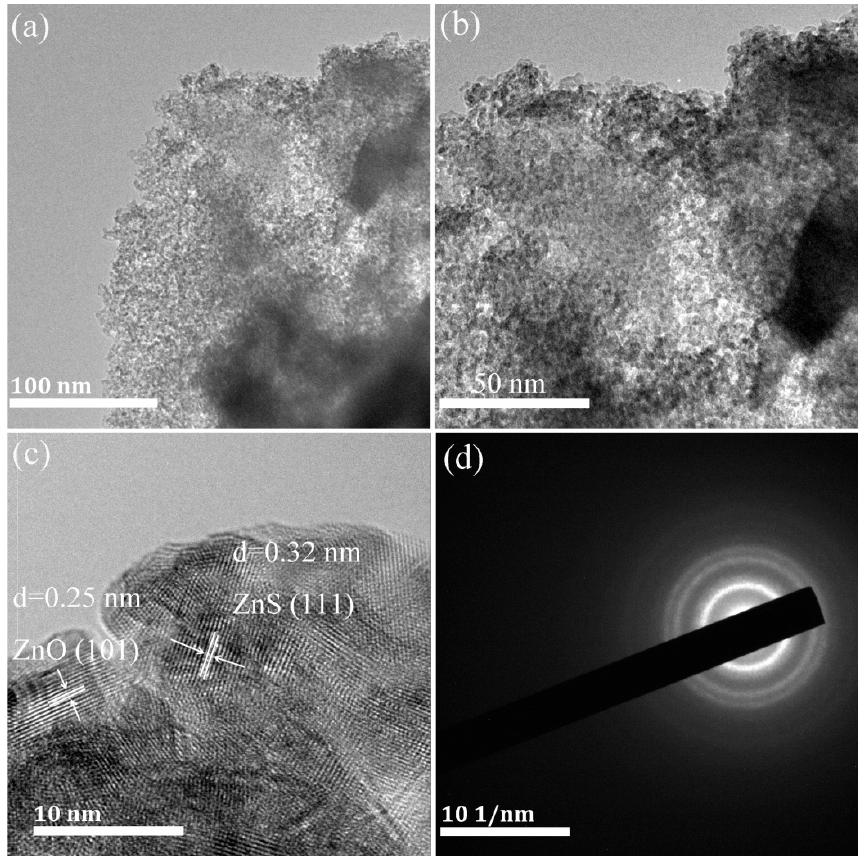
Figure 3. TEM images ( a,b ), the corresponding HRTEM image ( c ), and SAED patterns ( d ) of ZOS-